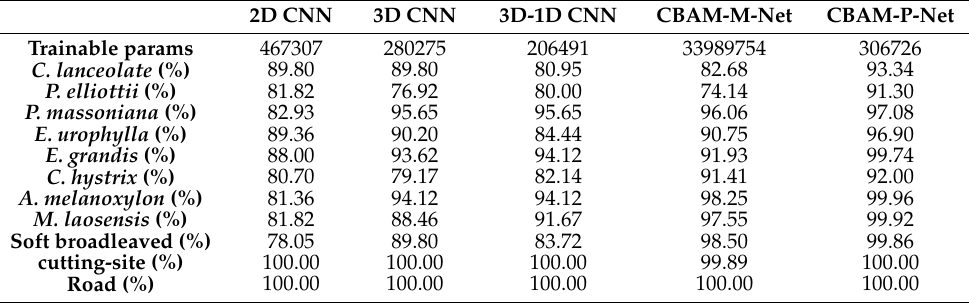
Table 10. Comparison of classification accuracy between CBAM-M-Net and CBAM-P-Net.